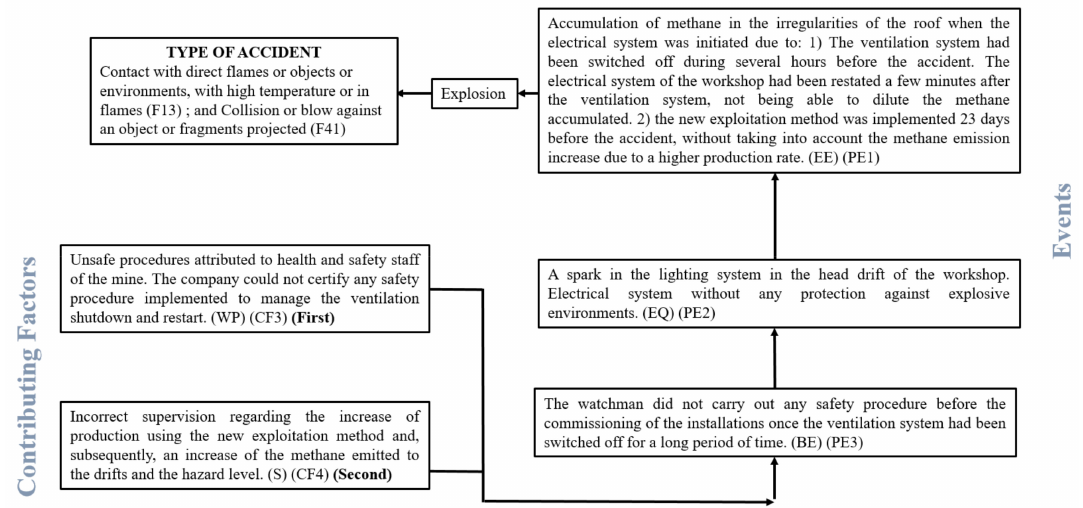
Figure 5. Causal tree using the Feyer and Williamson